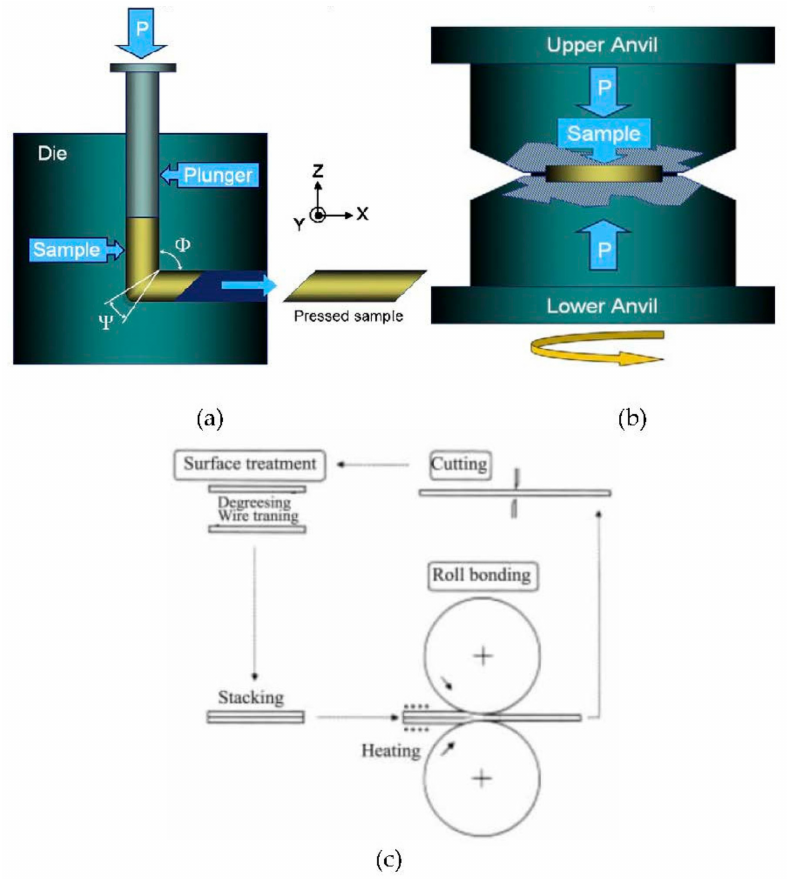
Figure 1. The schematics of ( a ) ECAP process including an X, Y, Z coordinate system [4]; ( b ) HPT process [4]; and ( c ) ARB process